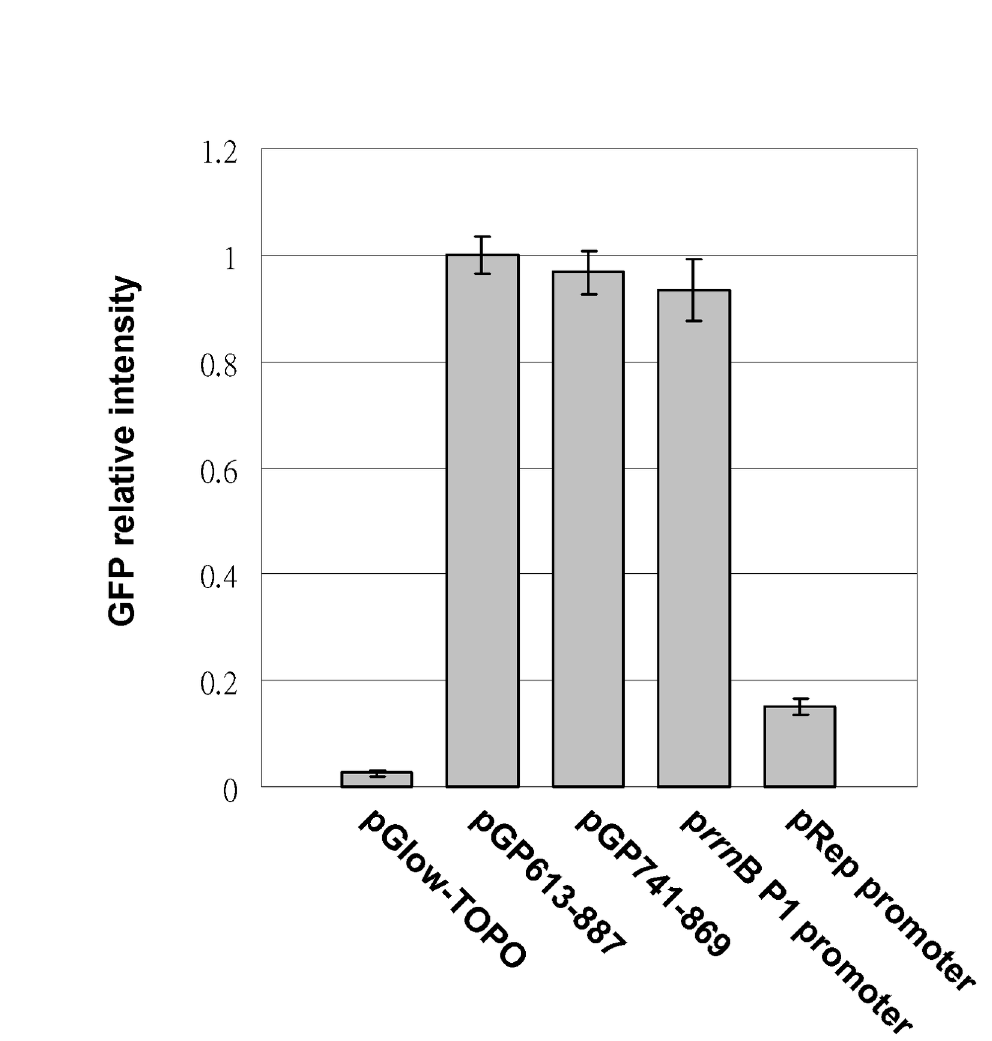
Figure 5. Comparison of promoter strengths. The strengths of different AV3 promoter regions (as indicated) were compared to that of the constitutive promoter, rrn B P1, and to the promoter for the Rep gene by fluorescence quantification as described in Figure